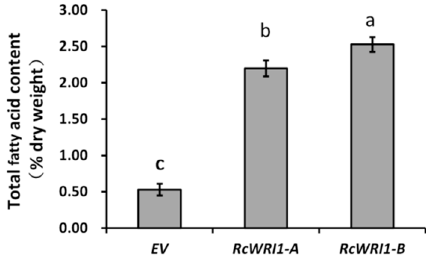
Figure 7. Total fatty acid content in N. benthamiana leaves expressing each of RcWRI1s . Fatty acids were extracted from the leaf samples and then transmethylated, followed by gas chromatography analysis. Fatty acid content was expressed as the percentage of leaf dry weight. EV indicates empty-vector control. Each value is the mean ± SE of twelve biological replicates. Letters a, b, c indicate a significant difference at the level p < 0.05 according to the Tukey’s test.